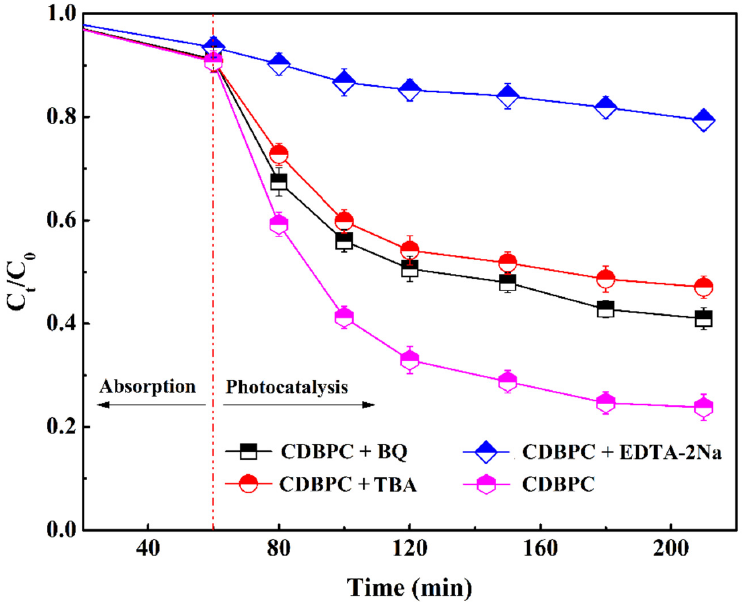
Figure 9. Effect of different quenchers on the photocatalytic degradation of TC.